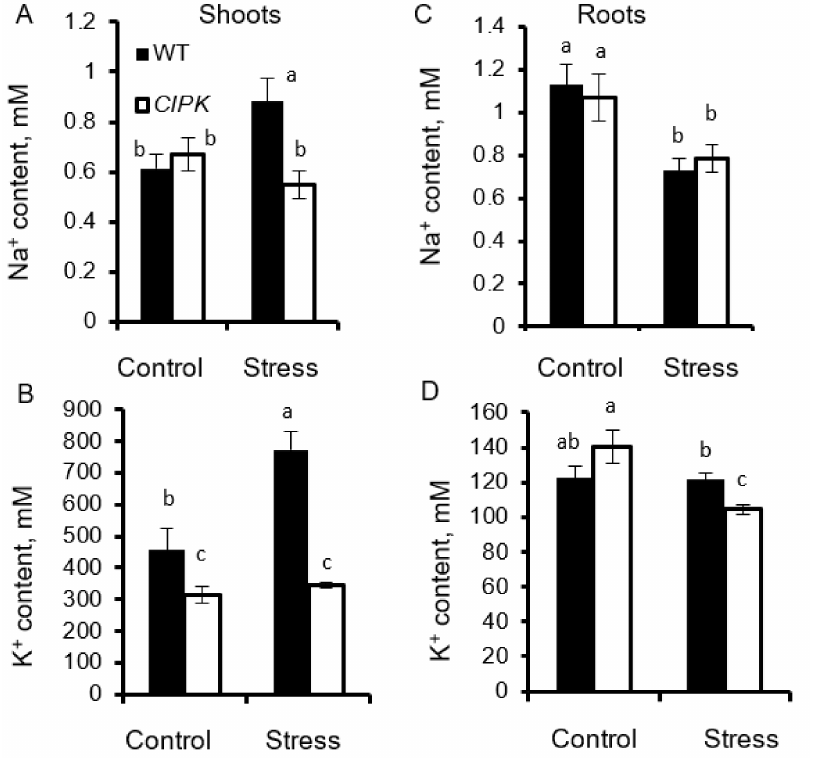
Figure 4. Effect of osmotic stress on plant ionic composition. ( A ) shoot Na + content, ( B ) shoot K + content; ( C ) root Na + content; and ( D ) root K + content. Plants of both lines were grown in a hydroponic system for 21 days and treated with PEG4000. Closed bars—WT; open bars—Oscipk9 mutant line. Data are the mean ± SE ( n = 6). Data labelled with different low-case letters is significantly different at p <